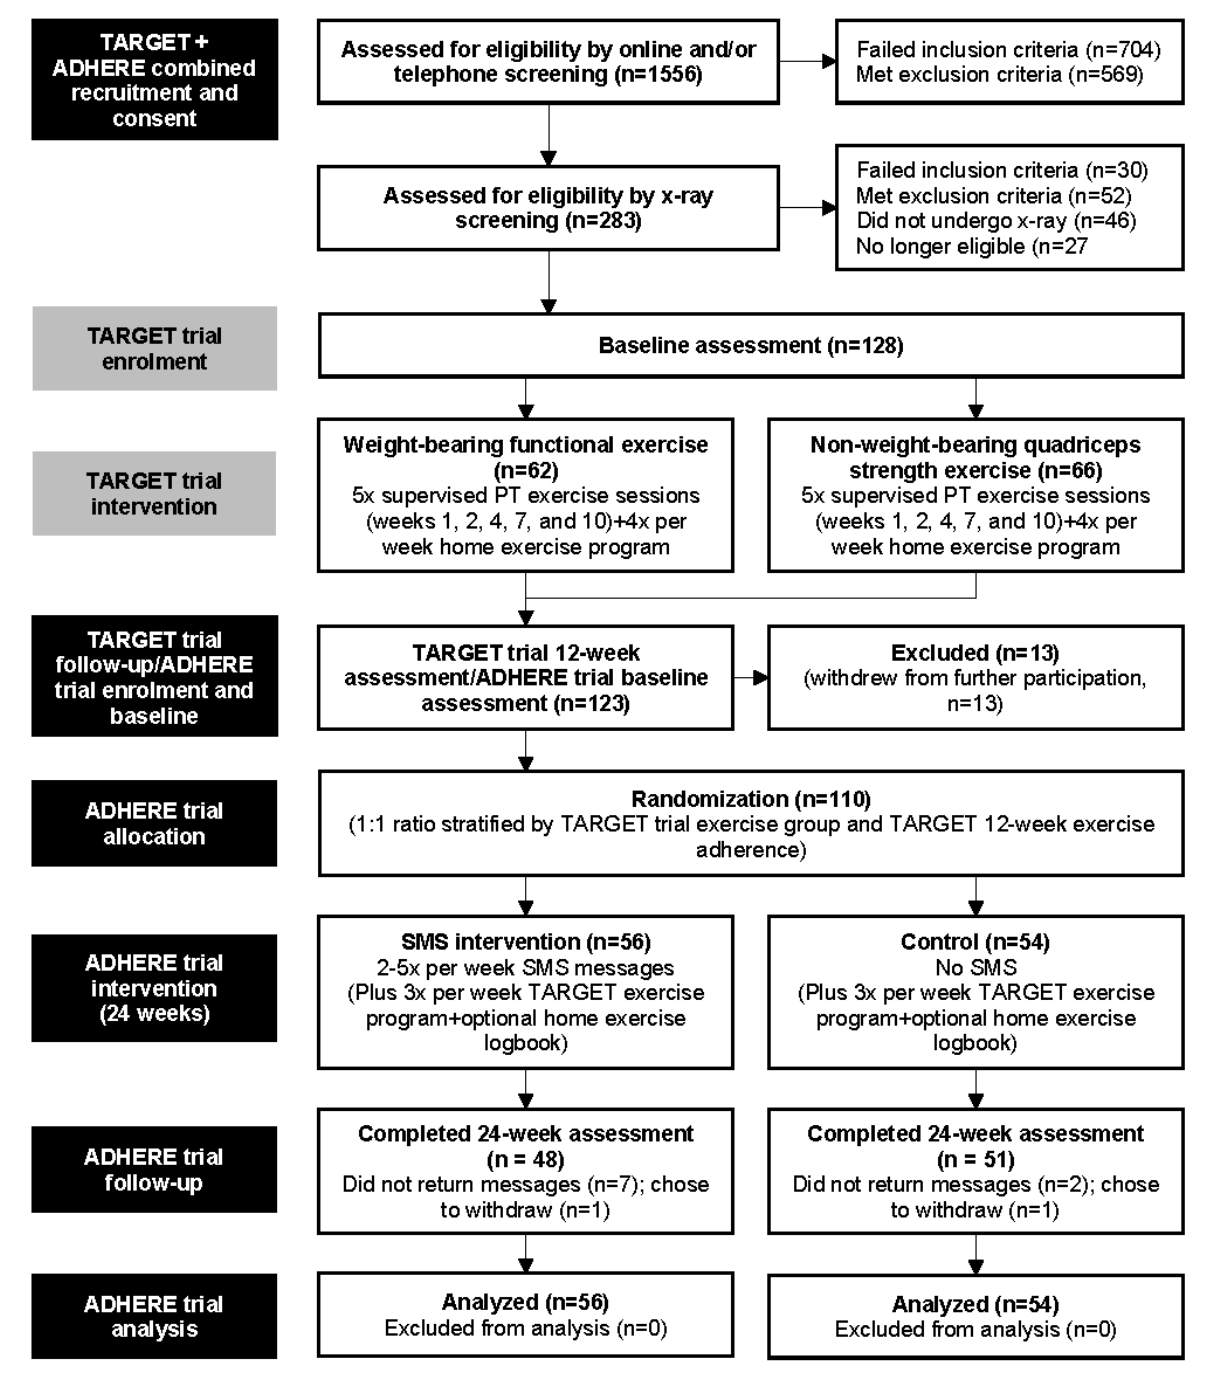
Figure 2. Flow diagram of preceding TARGET trial and ADHERE trial procedures. PT: